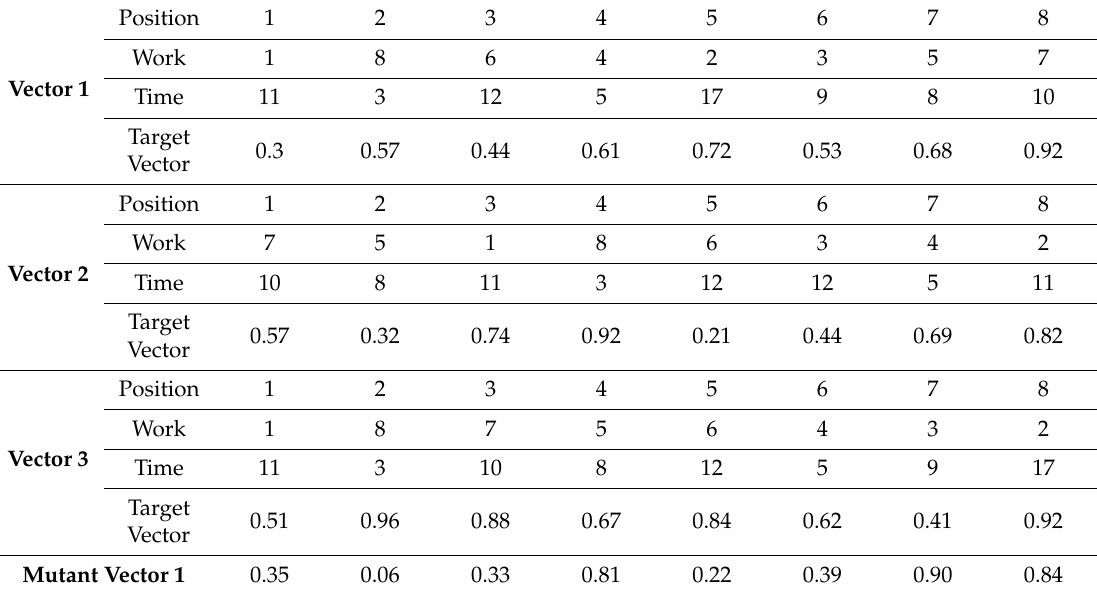
Table 2. Results of Mutation in Vector 1 by using